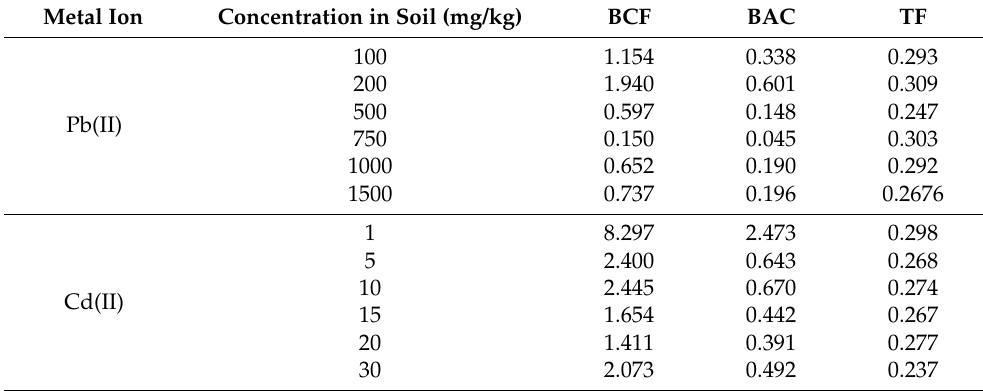
Table 2. BCF, BAC and TF of Brassica napus L. at different levels of lead and cadmium in soil.